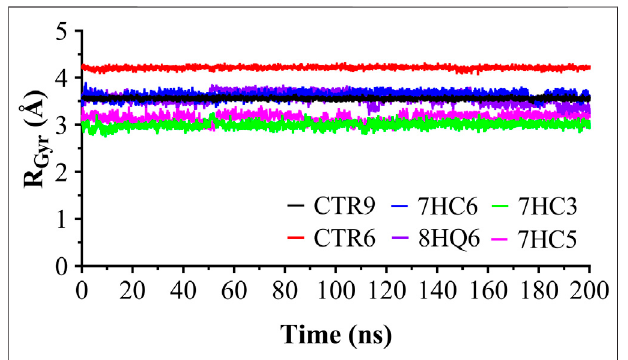
FIGURE4| RadiusofgyrationfortheSARS-CoV-2M pro incomplexwith CTR9, 7HC6, CTR6, 7HC3, 8HQ6 and 7HC5, during 200 ns simulation